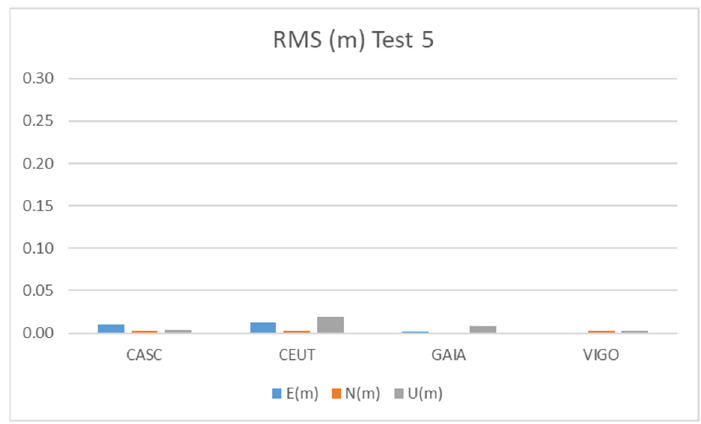
Figure 17. RMS results for Galileo + GPS combination at Test 5.